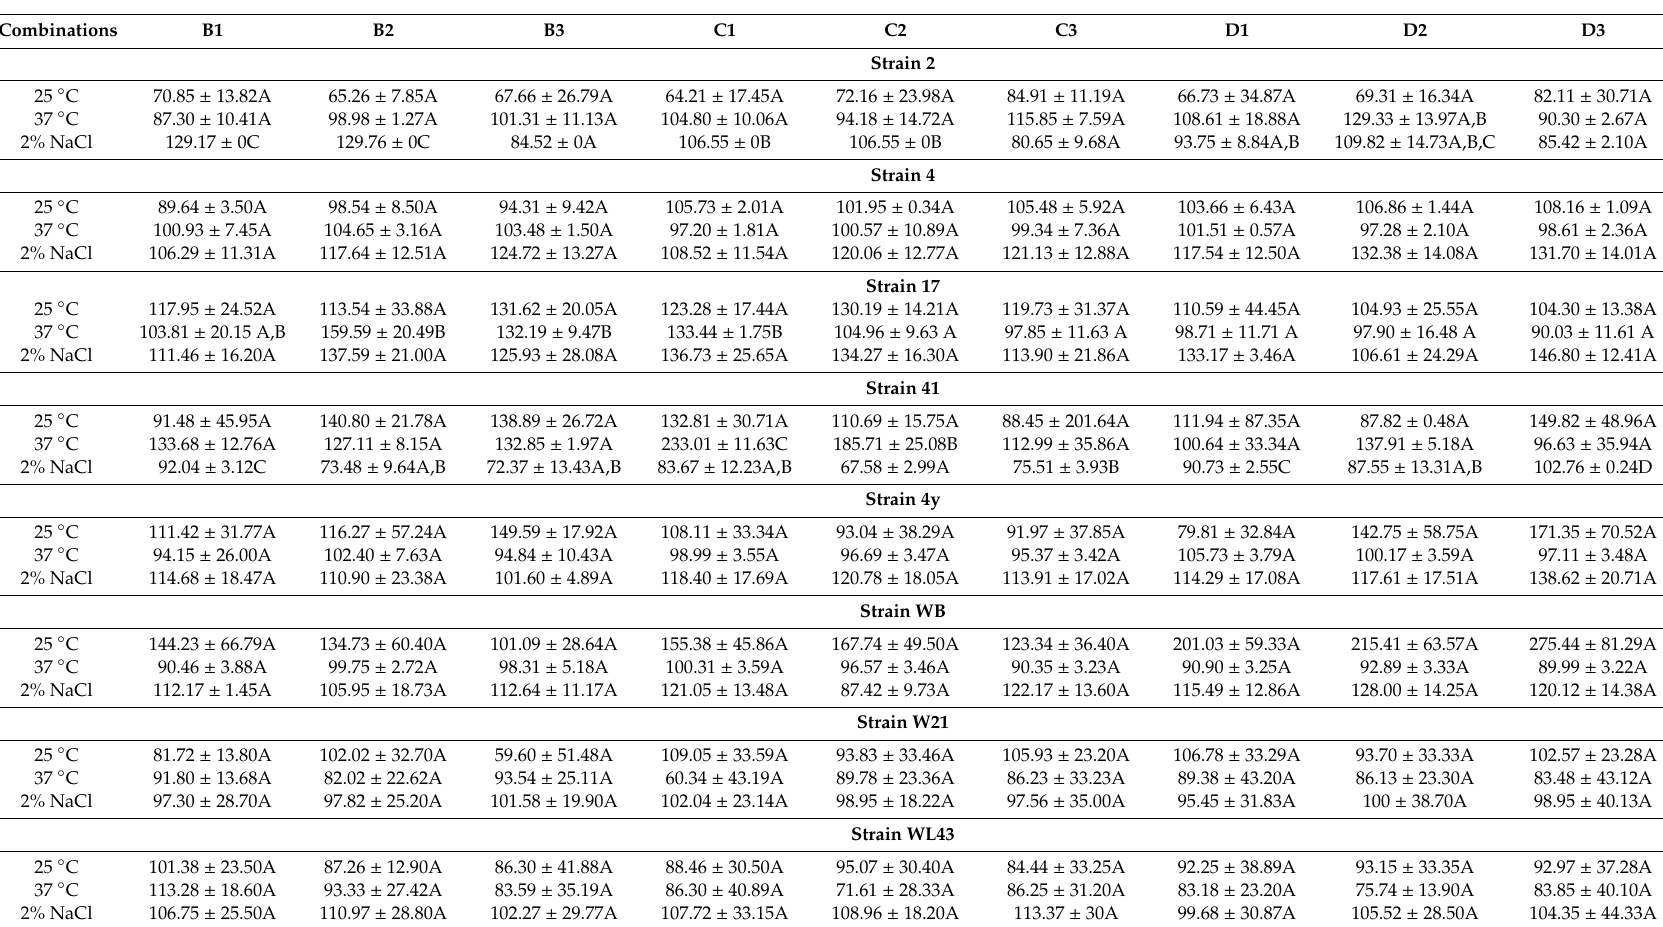
Table 3. Growth Index (%) of US-treated strains ( S. cerevisiae 2, 4, 17, 41, 4y, WB, W21 and WL43) in YPG broth incubated at 25 and 37 ◦ C or in presence of 2% NaCl after 48 h. The growth index was evaluated as the ratio absorbance of treated yeasts vs. absorbance of untreated yeasts (combination A1). Mean values ± standard deviation. The letters indicate significant di ff erences in a line (one-way ANOVA and Tukey’s test, p < 0.05).